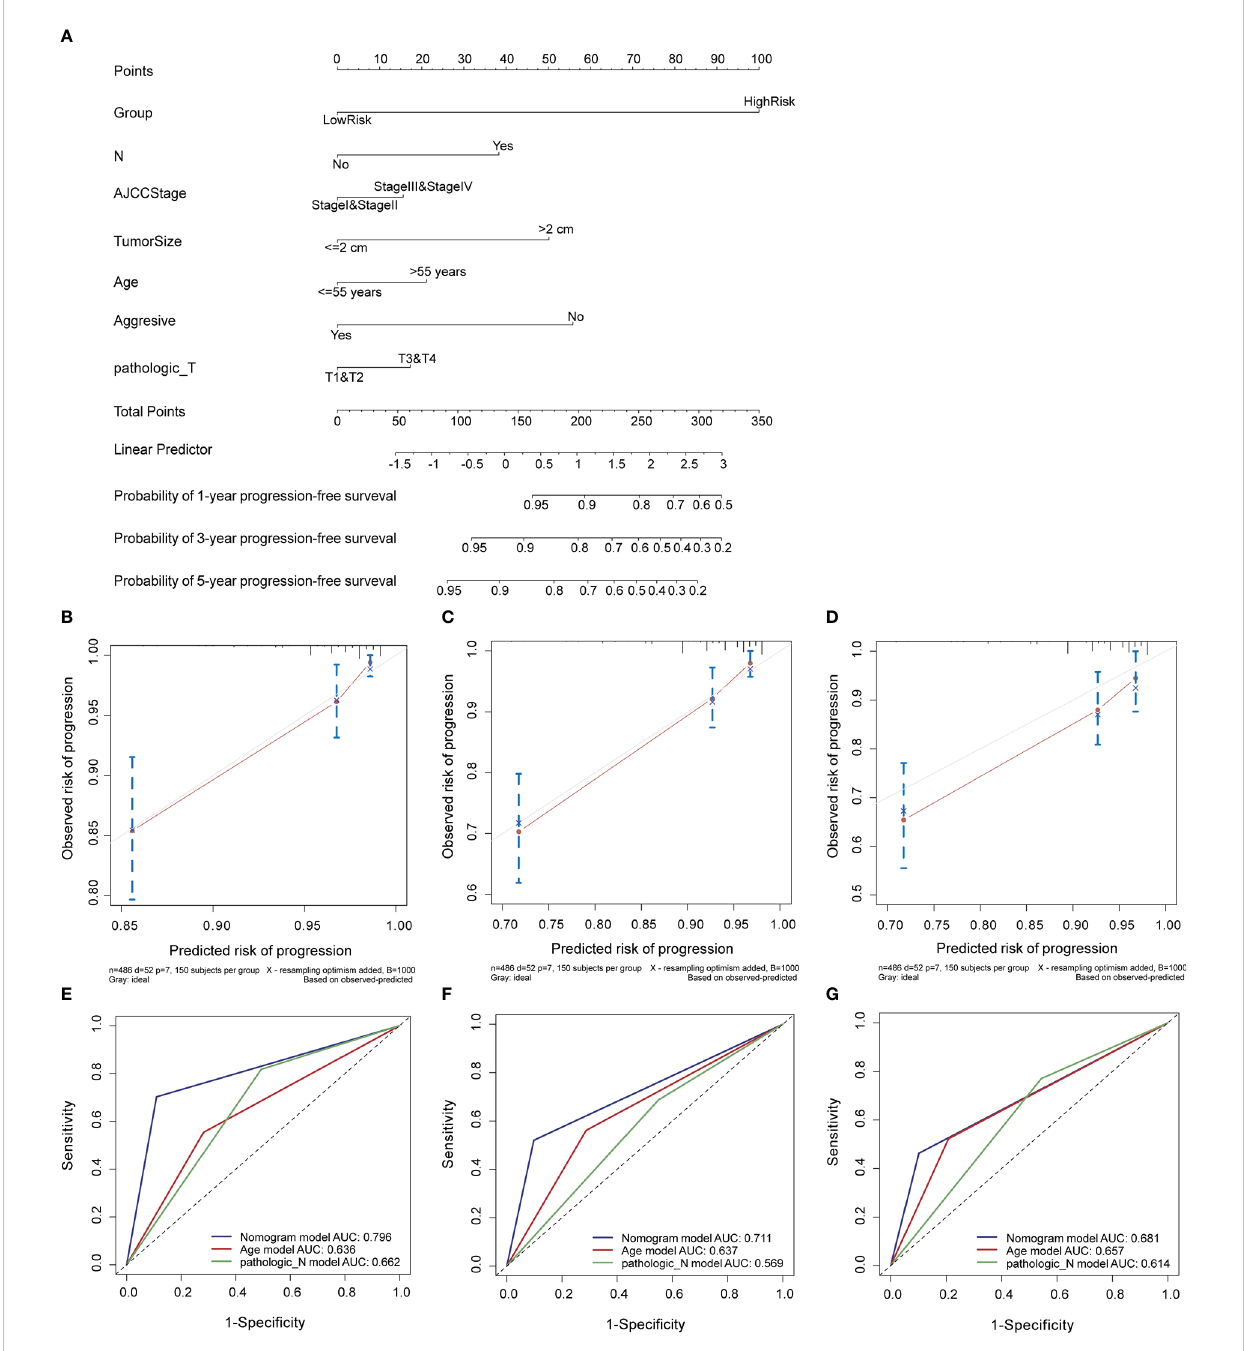
FIGURE 5 Construction and evaluation of a nomogram in the entire cohort. (A) Nomogram established to predict 1-, 3-, and 5-year PFI of PTC. (B – D) Calibration curves assessed the concordance between predicted and observed 1-, 3-, and 5-year PFI. (E – G) The ROC curves of the nomogram and other clinical characteristics at 1-, 3-, and 5-year time points. PFI, progression-free